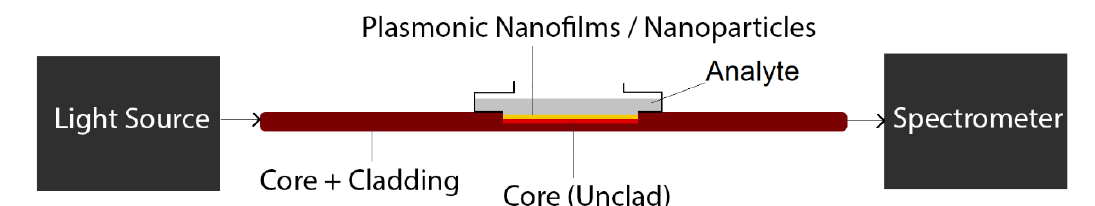
Figure 2. The schematic of a potential plasmonic biosensing setup based on unclad (exposed core) optical fibers.